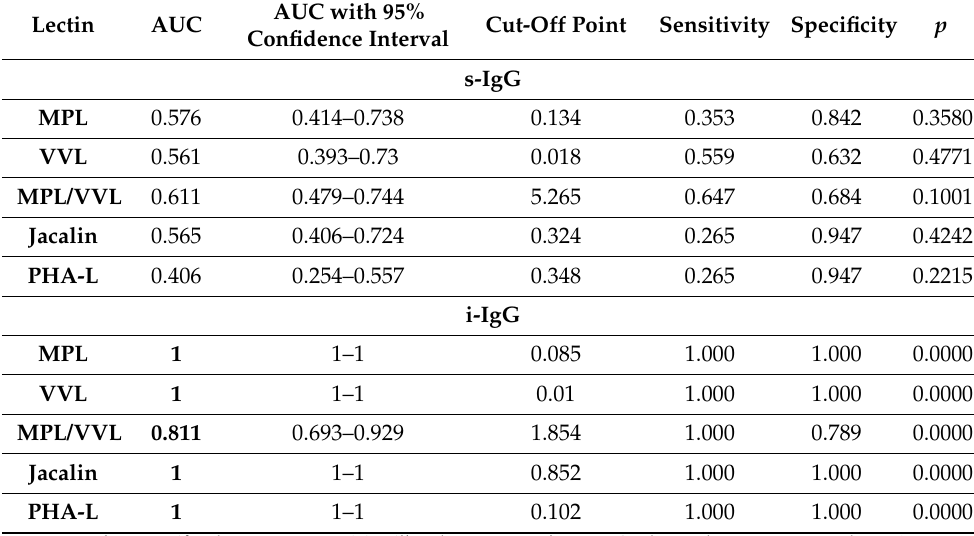
Table 4. Values of ROC curve analysis of s-IgG and i-IgG glycans’ relative reactivities with lectins for women with advanced endometriosis and healthy subjects. AUC with 95% Cut-Off Point Sensitivity Confidence Interval